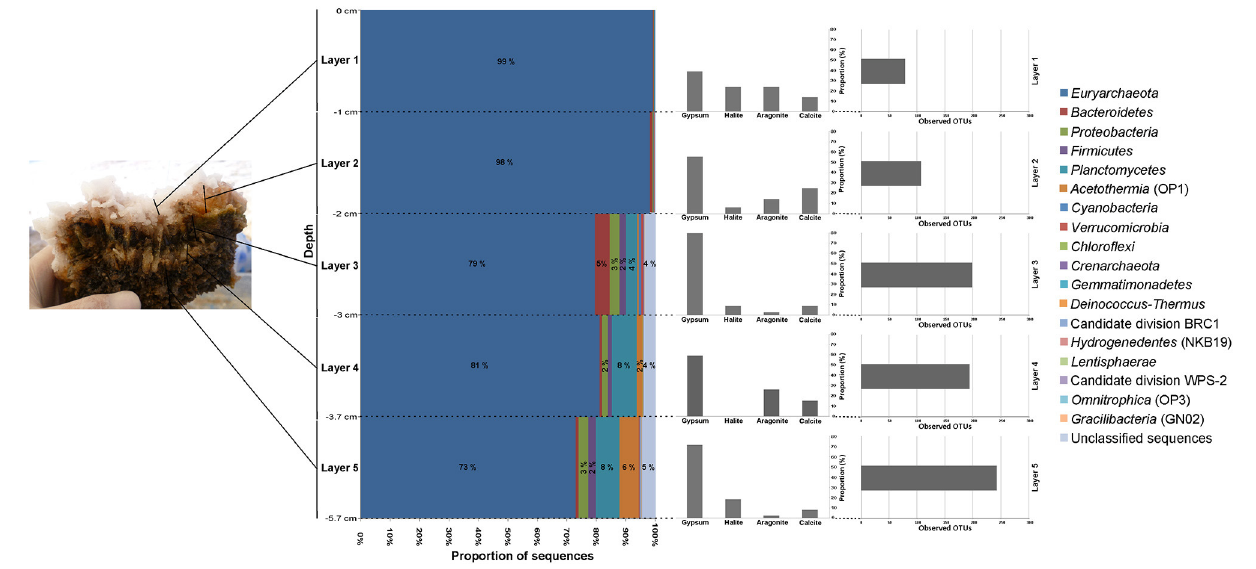
FIGURE 8 | Taxonomic composition by layers in EVD. Sequences were assigned taxonomically using Greengenes database with a minimum percentage similarity of 97% and a minimum e -value of 10 − 5